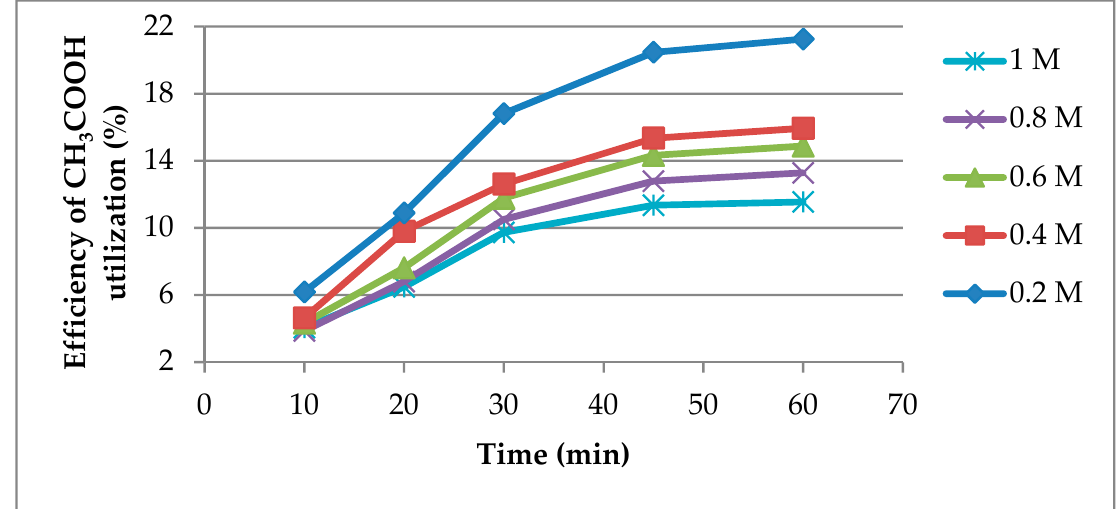
Figure 2. Efficiency of CH 3 COOH utilization vs. time at different CH 3 COOH concentrations. This tendency can be attributed to a partial order of reaction regarding CH 3 COOH concentration which means that the amount of acetic acid transformed in the leaching reaction does not increases proportional with the increase in initial CH 3 COOH concentra- tion. The concentration profiles of Pb 2+ shown in Figure 3 sustain the above explanation, considering that the total amount of lead dissolved increases only 171% by increasing the initial concentration of CH 3 COOH by